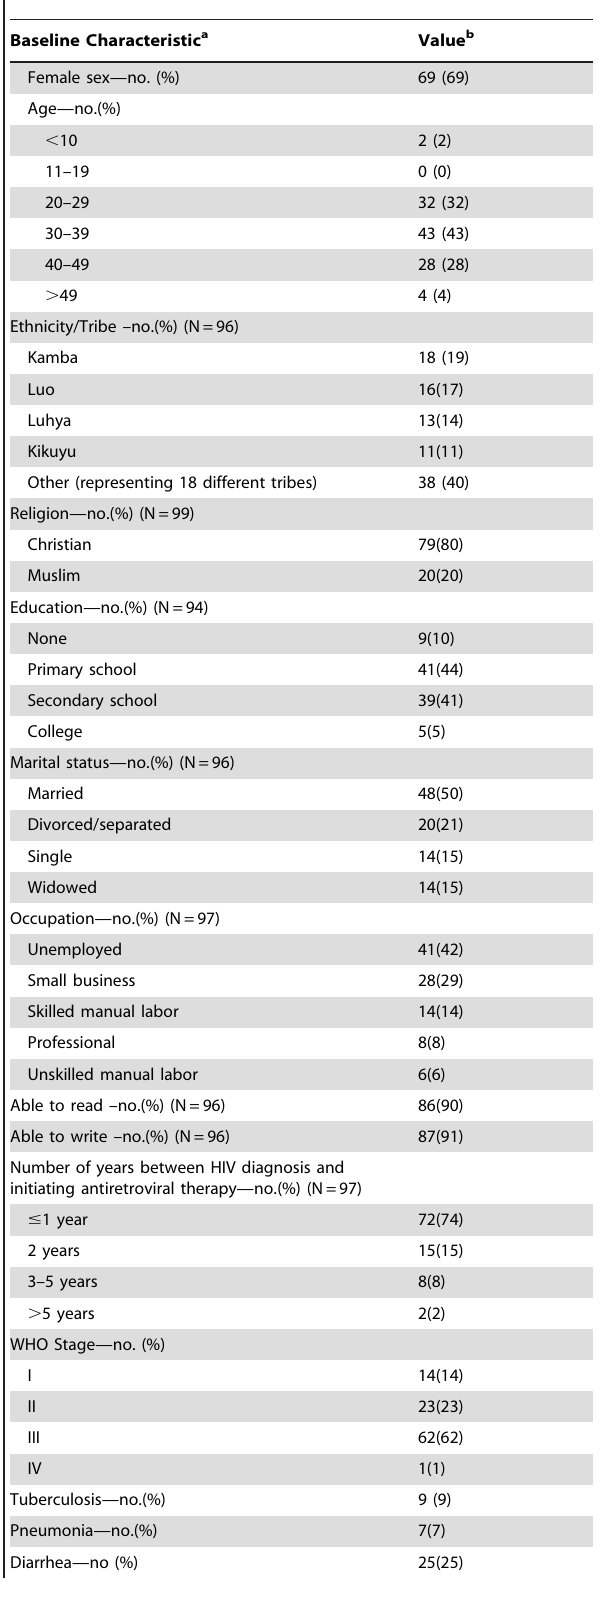
Table 1. Baseline characteristics of study participants.